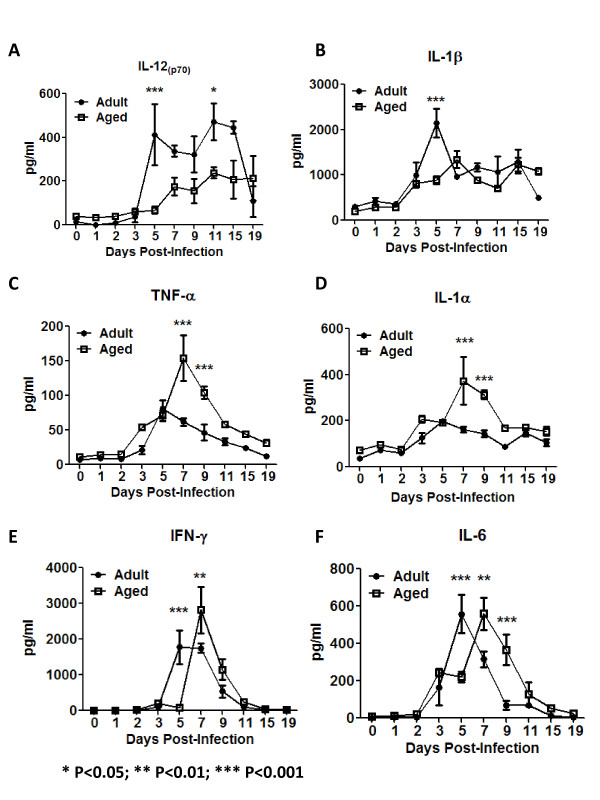
Pro-inflamatory and lymphocytic cytokines. The concentration of several pro-inflamatory and lymphocytic cytokines was determined in the supernatants of lung homogenates. IL-12p70 (NK and CD4 T-cell stimulant) was produced earlier and at significantly higher levels in adult mice (black circles) (A), which correlated with an earlier detection of IFN-γ in adult animals. IL-1β concentrations peaked at day 5 post-infection in adult mice (black circle), but steadily increased in aged mice (B). TNF-α and IL-1α concentrations increased similarly in both adult and aged mice until day 5 and then declined over the 19 days of observation in adult animals (black circles)(C and D). In contrast, these two cytokines continued to increase in aged mice (white squares) with significantly higher concentrations at day 7-9 post-infection (C and D). The lymphocytic cytokines, IFN-γ and IL-6, spiked earlier in adult mice (black circles) (E and F). The graphs represent cumulative results of two different experiments. The arithmetic mean (± SEM) of the cytokine(s) concentration of 4-6 mice assayed at each time point was plotted. Stars indicate statistical difference between aged and naïve animals.*P < 0.05. **P < 0.01. ***P < 0.001.